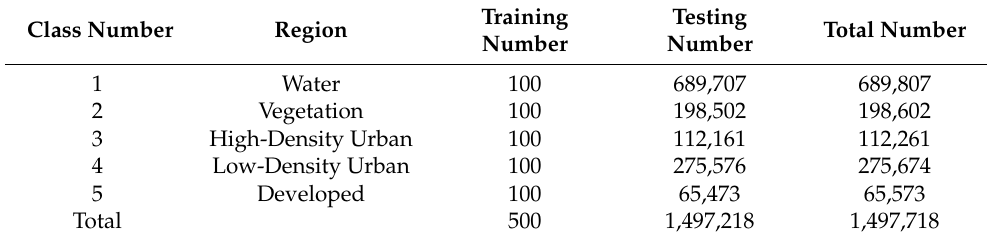
Table 4. Training and testing samples of the San Francisco